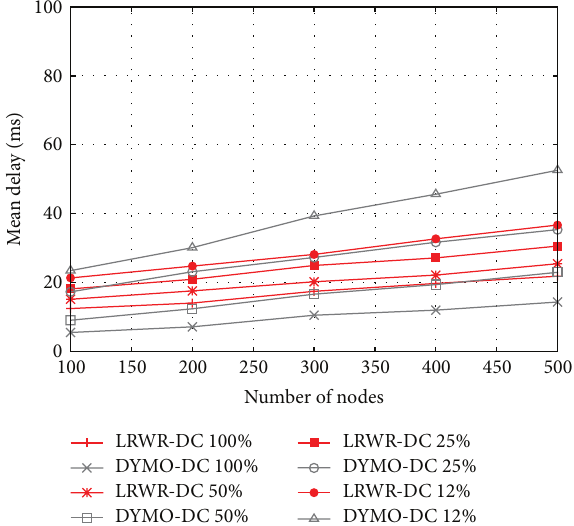
Figure 5: Packet delivery ratio versus total number of nodes. Figure 6: Mean delay versus total number of nodes.